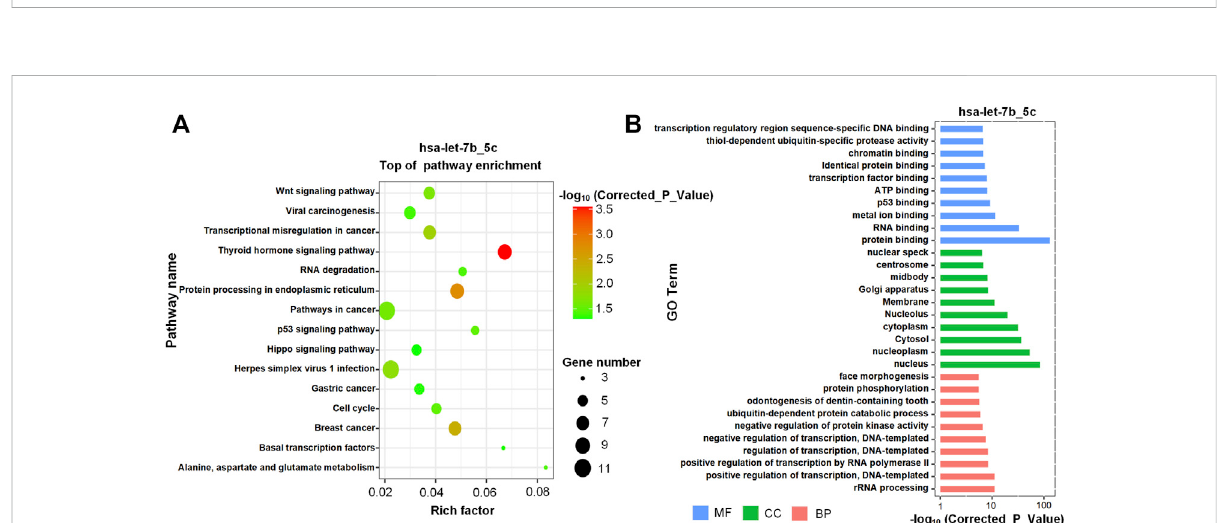
FIGURE 6 The enriched KEGG pathways and GO terms of new targets of hsa-let-7b_5c (A) The enriched KEGG pathways of the new targets of hsa-let- 7b_5c. (B) The mostsigni fi cantGO termsofthenew targets ofhsa-let-7b_5c. The GO termswith thesmallestcorrected p -valuesinthethree